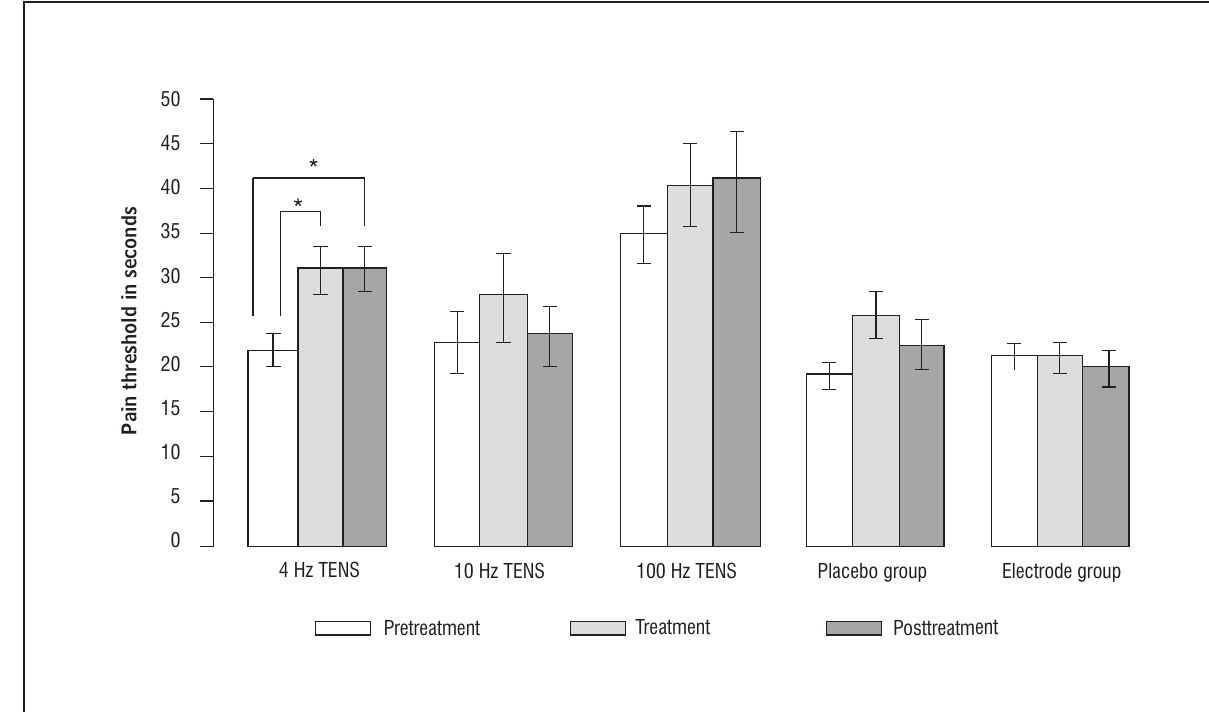
Figure 3 - The arithmetic mean of the pain threshold in seconds for the five groups of subjects in the three experimental steps Note: The vertical lines in each bar represent the standard error of the mean and the asterisk (*) denotes p-value < 0.05. A significant in- crease in pain threshold of 4 Hz TENS group from the first to the second stage occurred, this increase remained until the third stage, while in the other groups there was no significant change between any of the